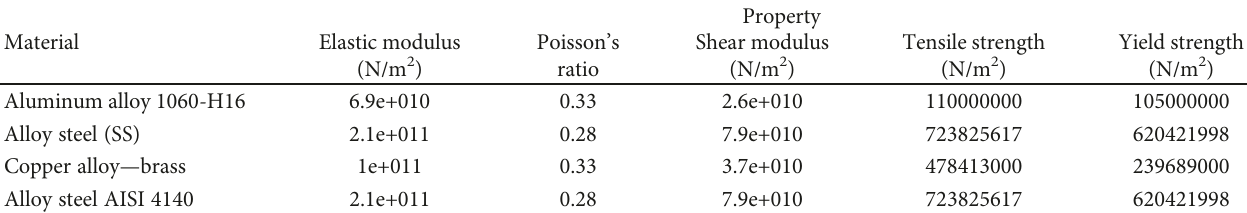
Table 3: Properties of the